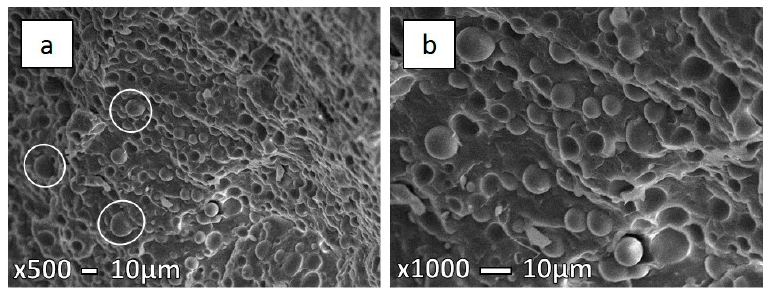
Figure 8. SEM micrographs of freeze-fracture surfaces in the parallel direction under liquid nitrogen of 70PP/30PET MFC at 230 ◦ C ( a ) low magnification ( × 600); and ( b ) high magnification ( × 1000).